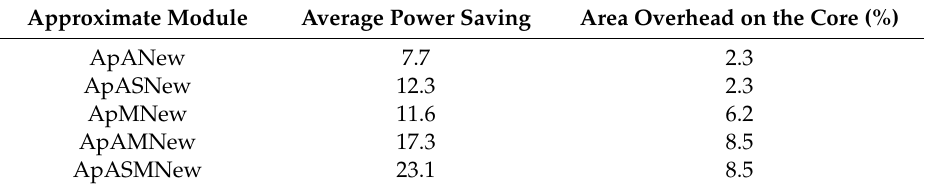
Table 6. Approximate blocks and their power saving for ASIC